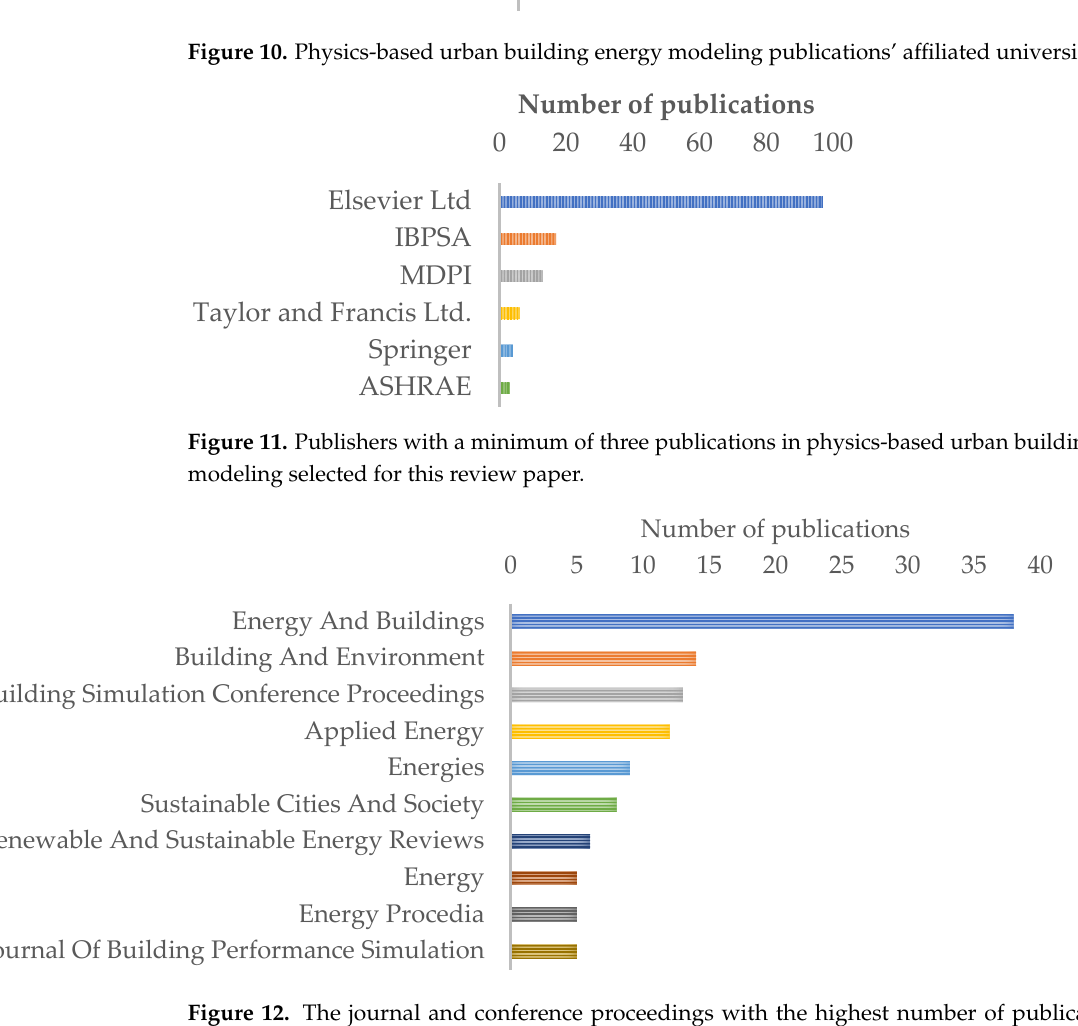
Figure 12. The journal and conference proceedings with the highest number of publications on physics-based urban building energy modeling.